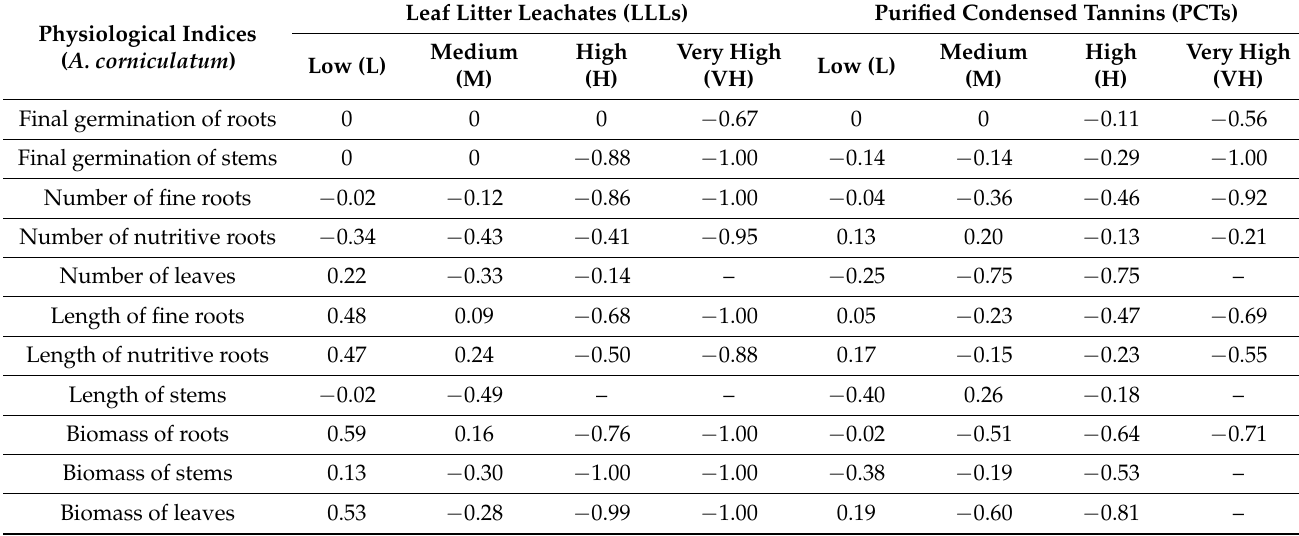
Table 1. Allelopathic response indices (RI) of the physiological performance of A. corniculatum under LLL and PCT treatments from K. obovata . Positive numbers mean forward effects, negative numbers mean inhibitive effects, 0 means no obvious effects, and–means no way to calculate